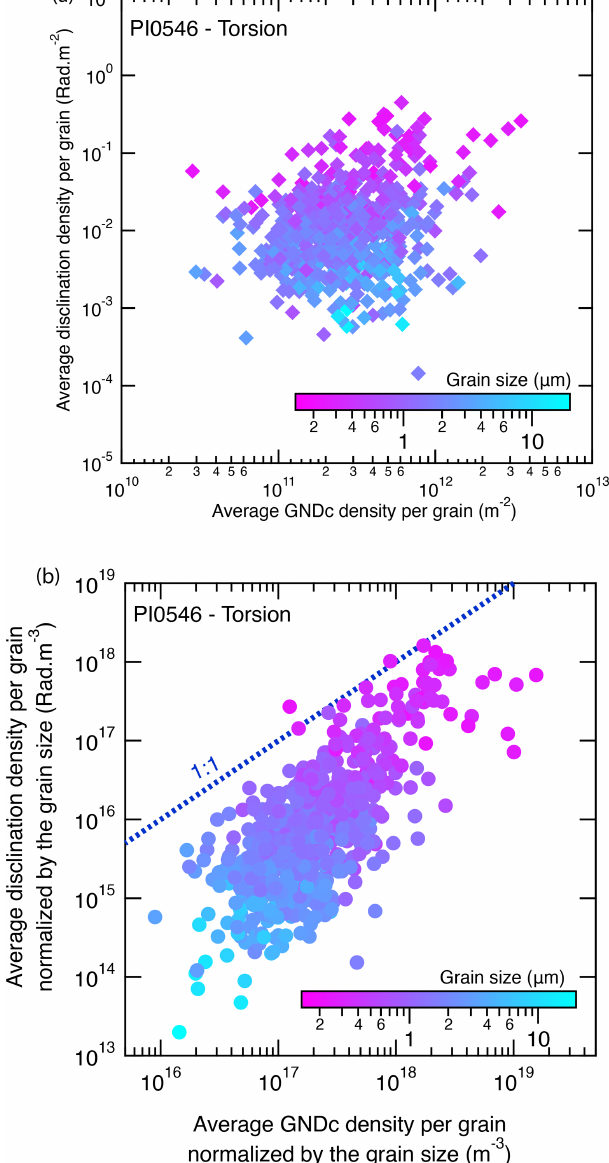
Figure 13. (a) Distribution of one-point-per-grain disclination den- sities as a function of the one-point-per-grain GNDc ( ρ c α ) den- sity for sample PI0546-III. (b) Distribution of one-point-per-grain disclination densities normalized to the grain size as a function of the one-point-per-grain GNDc density normalized to the grain size of sample PI0546-III. The data points are color-coded according to the associated grain size. The dashed dark-blue line is a guide for the eye with a 1 : 1 slope, showing that the correlation is not only due to grain size distribution. The step size is 0.1µm (original ac- quisition step